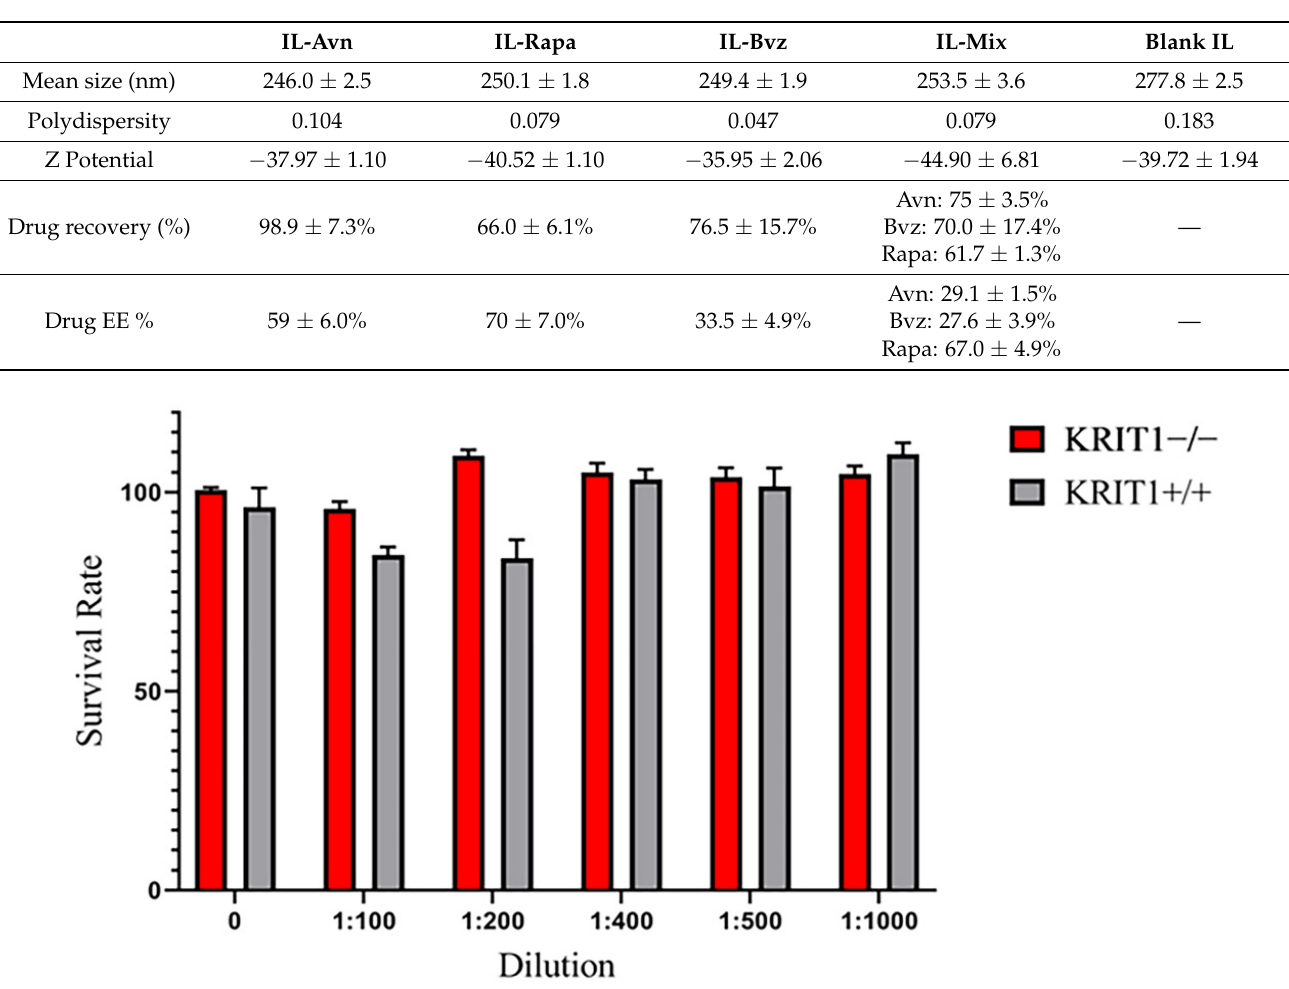
Table 1. Physicochemical characterization of blank and drug-loaded ILs. Abbreviations: Avn: yeast